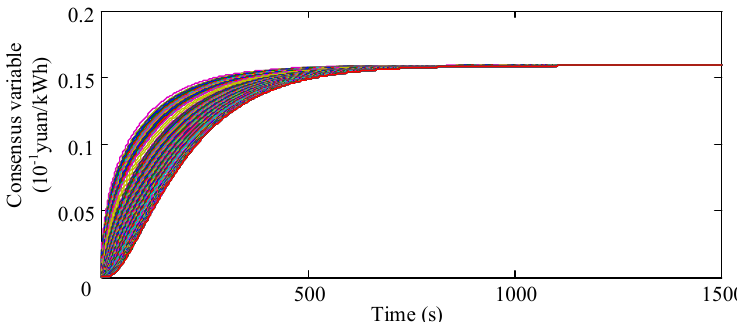
Figure 12. Curves of the consensus variable of each EV under the non-hierarchical control.